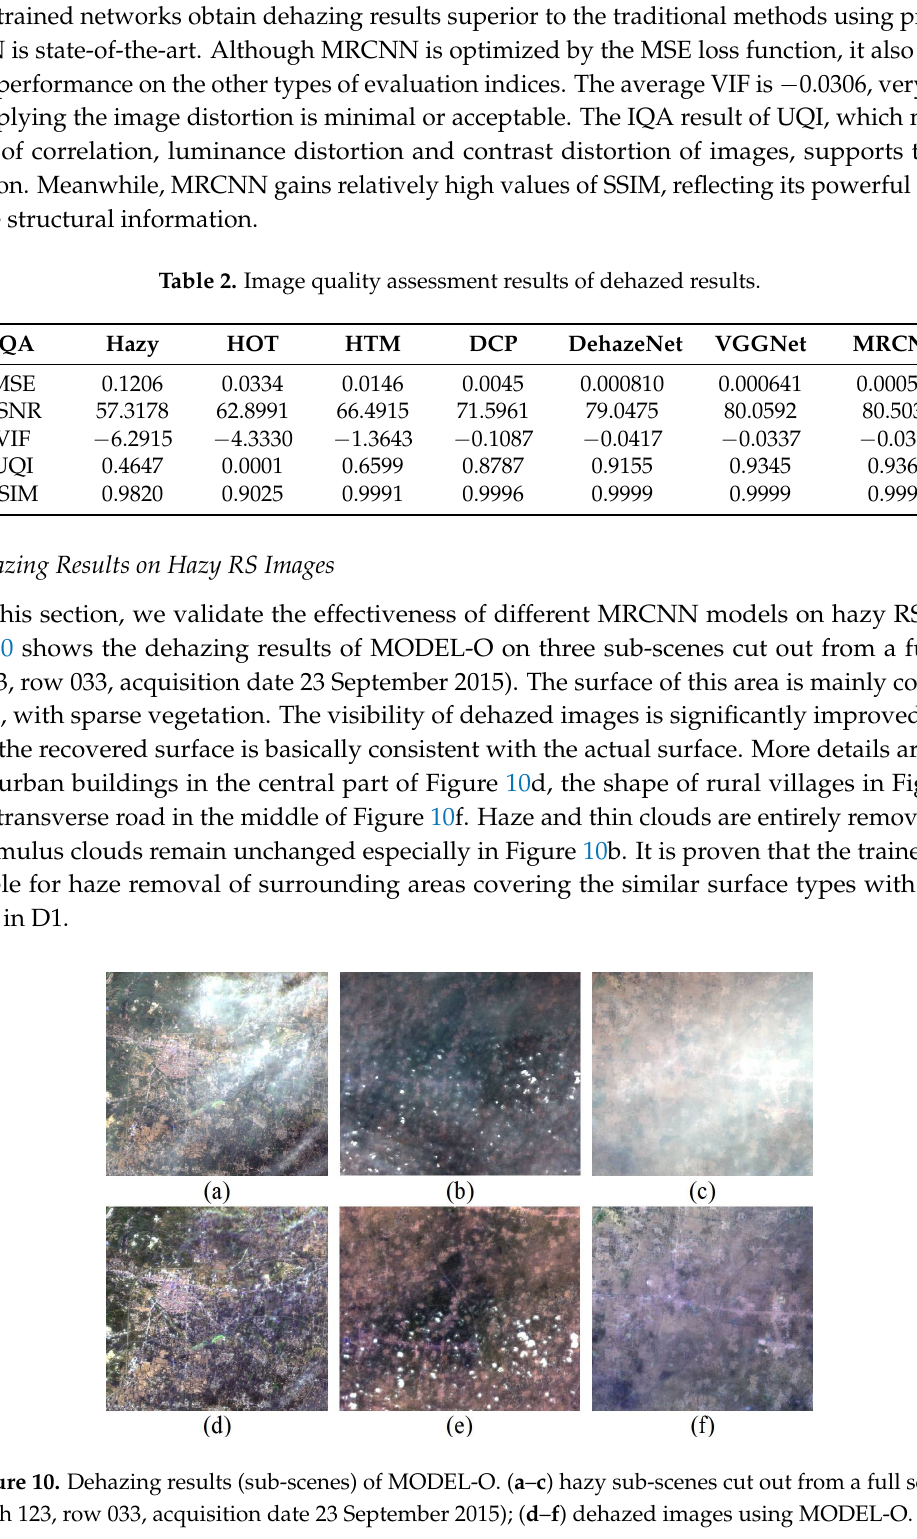
Table 2. Image quality assessment results of dehazed results.